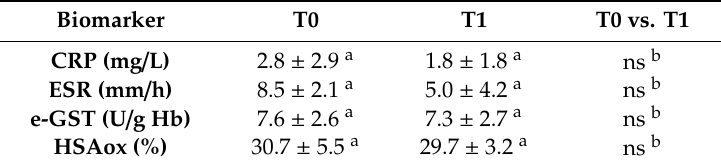
Table 8. Inflammatory and oxidative stress biomarkers of healthy subjects.